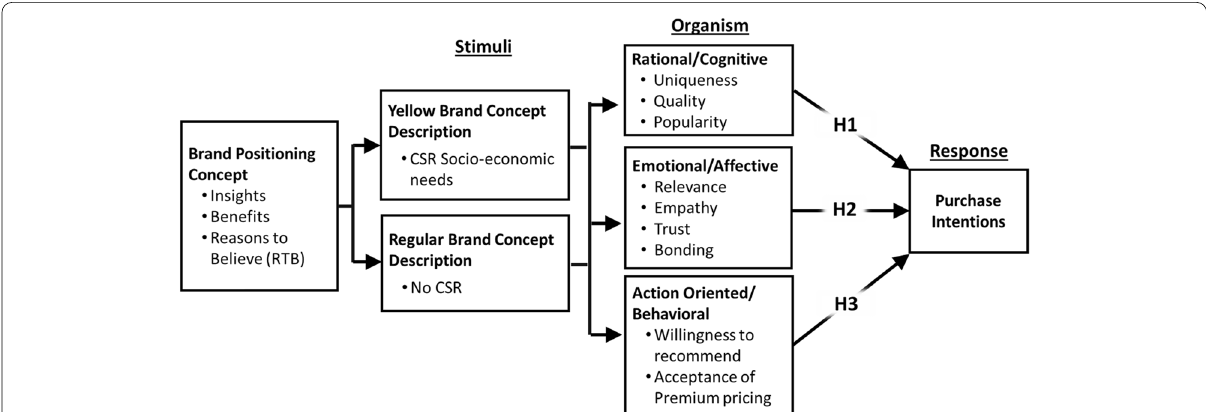
Fig. 1 Stimulus-Organism-Response Model for Consumer Perceptions and Purchase